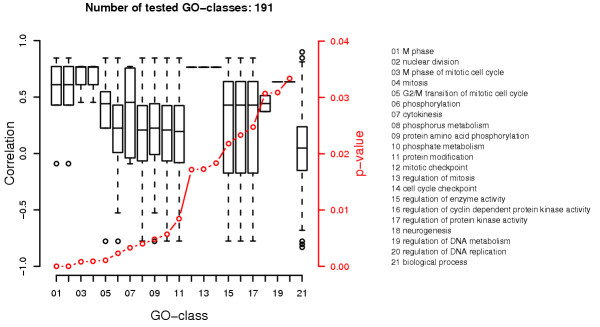
Correlations and p-values of the expression dataset from Zhao. Analogous to figure 3